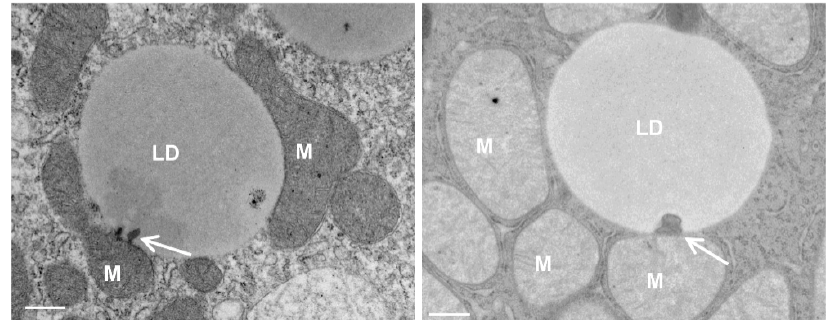
Figure 6. Dot-like mitochondria–LD contact sites in fasted mouse livers. C57Bl/6J mice were fasted overnight and liver tissues were collected followed by EM analysis (experimental details see ref. [67]). Representative EM images from mouse livers are shown. White arrows denote electron-dense dot-like mitochondria–LD contacts. LD: lipid droplet; M: mitochon- dria; P: peroxisome. Bar: 500 nm.